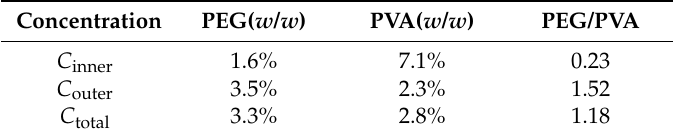
Table 2. The concentration of materials in the aqueous two-phase system